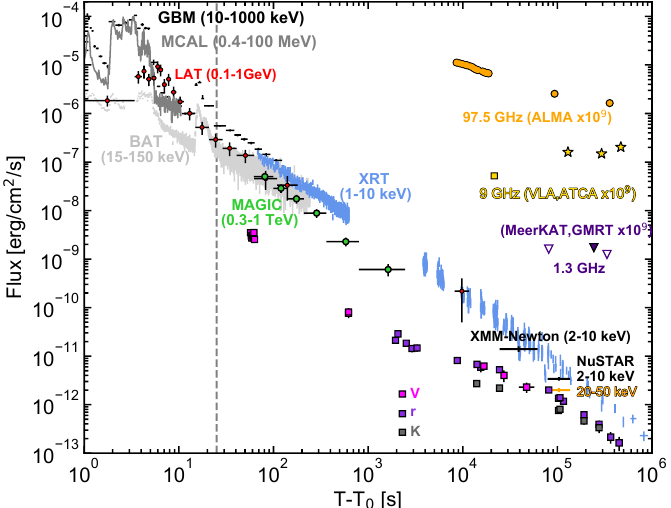
Figure 17. GRB190114C: light-curves at different frequencies. From